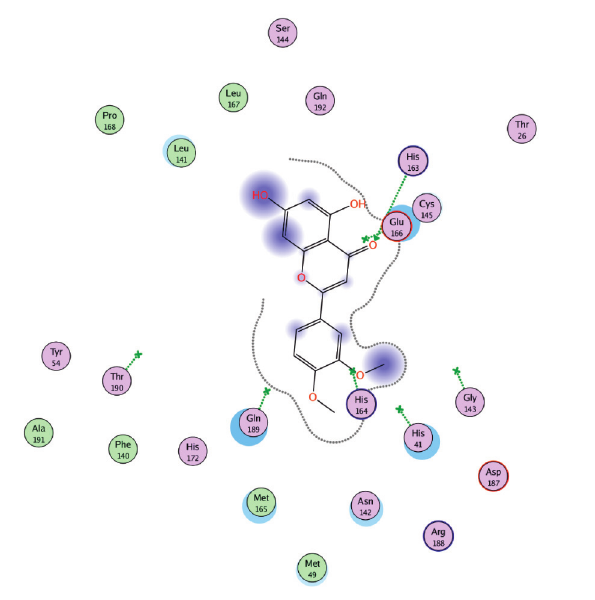
Figure 7: 2D interaction of compound (2) in the active site of the COVID-19 main